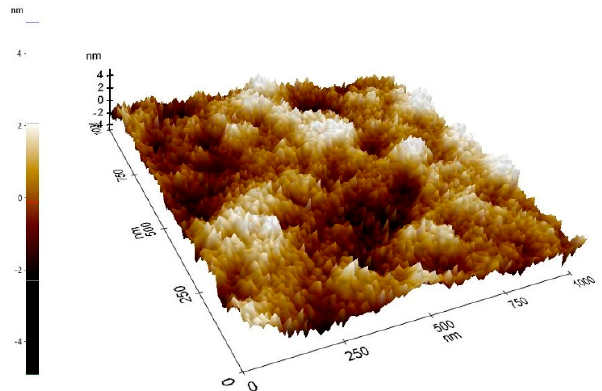
Figure 11. Surface image taken from AFM measurement for PTB7:PC 71 BM which is deposited directly onto PEDOT:PSS layer via dynamic spin coating. Reproduced with the permission from Stylianakis et al. [17], Dyes and Pigments; published by Elsevier, 2017.